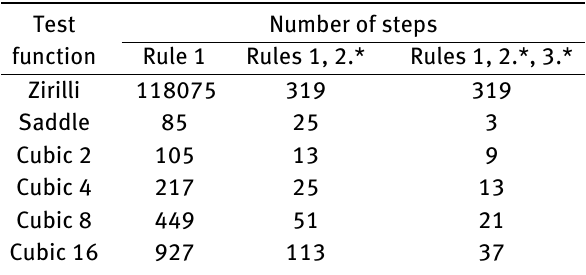
Table 1: Comparison of different search